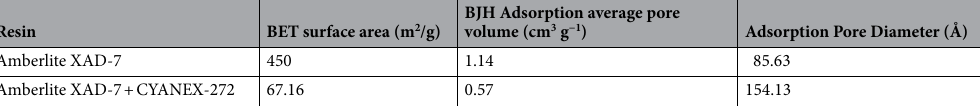
Table 3. Surface properties of Amberlite XAD ‒ 7 and CYANEX-272 impregnated Amberlite XAD ‒ 7.